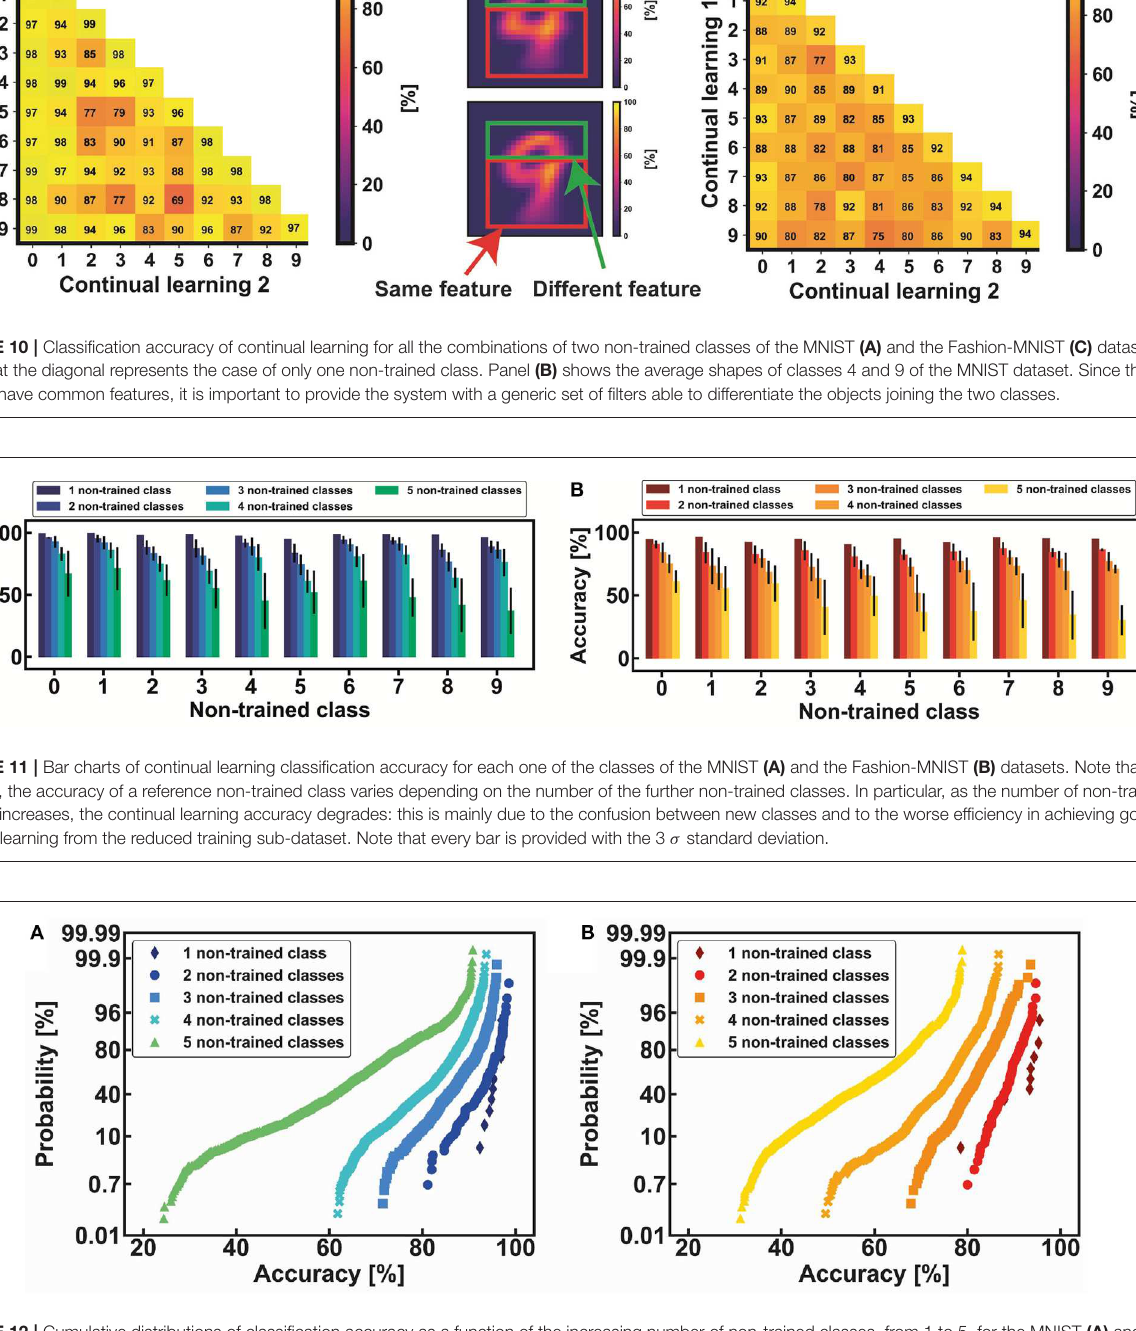
using the internal software of Xilinx, Vivado. On the other hand, the power analysis of a hardware realization based on PCM synapses has been studied referring to the PCM devices described in Bianchi et al. (2019) and to a peripheral circuitry